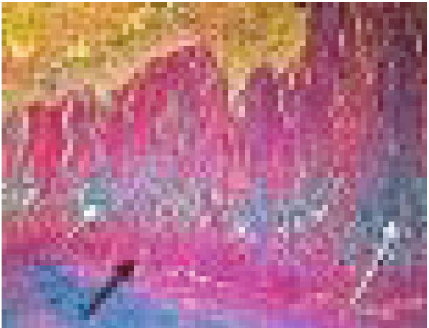
Figure 38: Muscular artery cystic necrosis. The black arrow points to preserved outer media, and the white arrows point to expanded alcian blue-positive extracellular matrix material in mid media. Movat stain × 25 (adapted from the World Journal Cardiovascular Diseases 2013.3 published online).